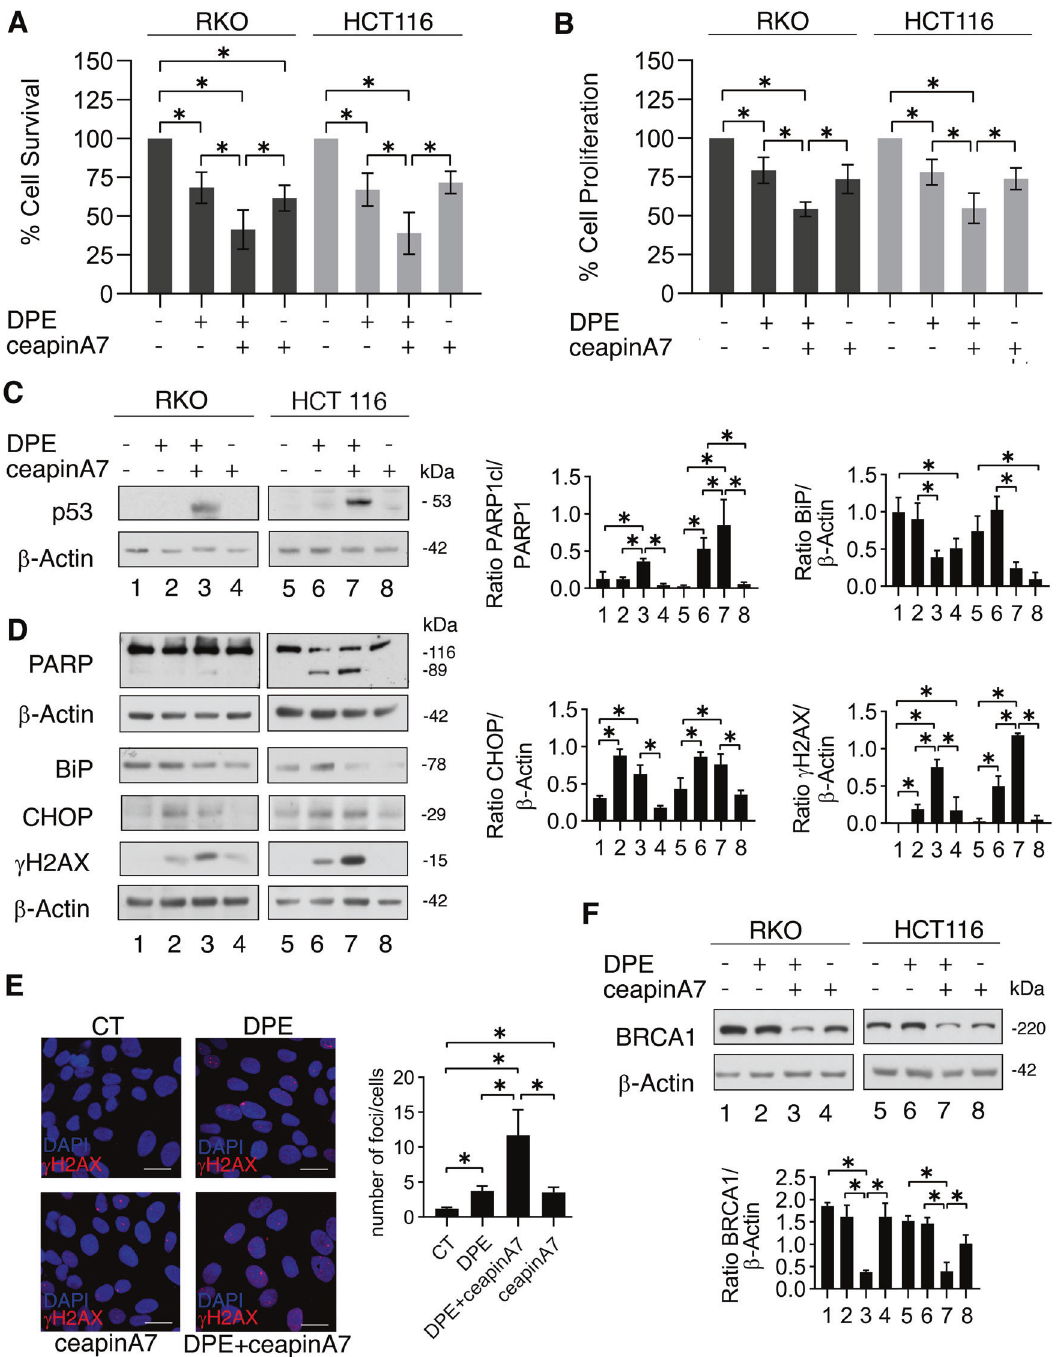
Fig. 1 ATF6 inhibition reduces survival in DPE-treated cells and increases DNA damage which correlates with BRCA-1 reduction. RKO and HCT116 cells were pre-treated or not with ceapinA7 (12 μ M) for 1 h and then treated or not with DPE (100 μ M) or left untreated, as control. After 48 h of treatments, A cell viability was measured by a Trypan Blue exclusion assay, the histograms represent the mean ± S.D. of live cells as percent of untreated control cells. By using the KERN index (R), we found that the combination of DPE plus ceapinA7 induced a synergistic cytotoxic effect in both RKO and HCT116 cells (R > 1). B Cell proliferation was measured by MTT assay, the histograms represent the mean ± S.D. of the ratio between the OD of treated cells and control cells. p value: *<0.05. C , D Protein expression level of p53, PARP cleavage, BiP, CHOP, γ H2AX was evaluated by western blot analysis. β -Actin was used as loading control and one representative experiment is shown. The histograms represent the densitometric analysis of the ratio of speci fi c protein and the appropriate control of three different experiments. Data are represented as the mean plus S.D. p value: *<0.05. E γ H2AX foci (red) were assessed by IFA in RKO cell line. DAPI (blue) was used for nuclear staining. One representative experiment out of three is reported. The histograms represent the mean plus S.D. of the number of foci/ cell from three different experiments. Bars = 20 μ m, p value: *<0.05. F Western blot analysis of BRCA-1 expression level. β -Actin was used as loading control and one representative experiment is shown. The histograms represent the densitometric analysis of the ratio of BRCA-1/ β -Actin of three different experiments. Data are represented as the mean plus S.D. p value: *<0.05.